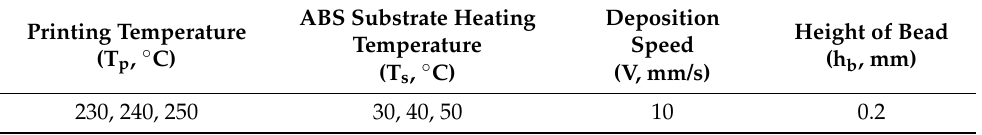
Table 5. Parameters for finite element model to investigate deposition process of PLA on ABS with plate heating.